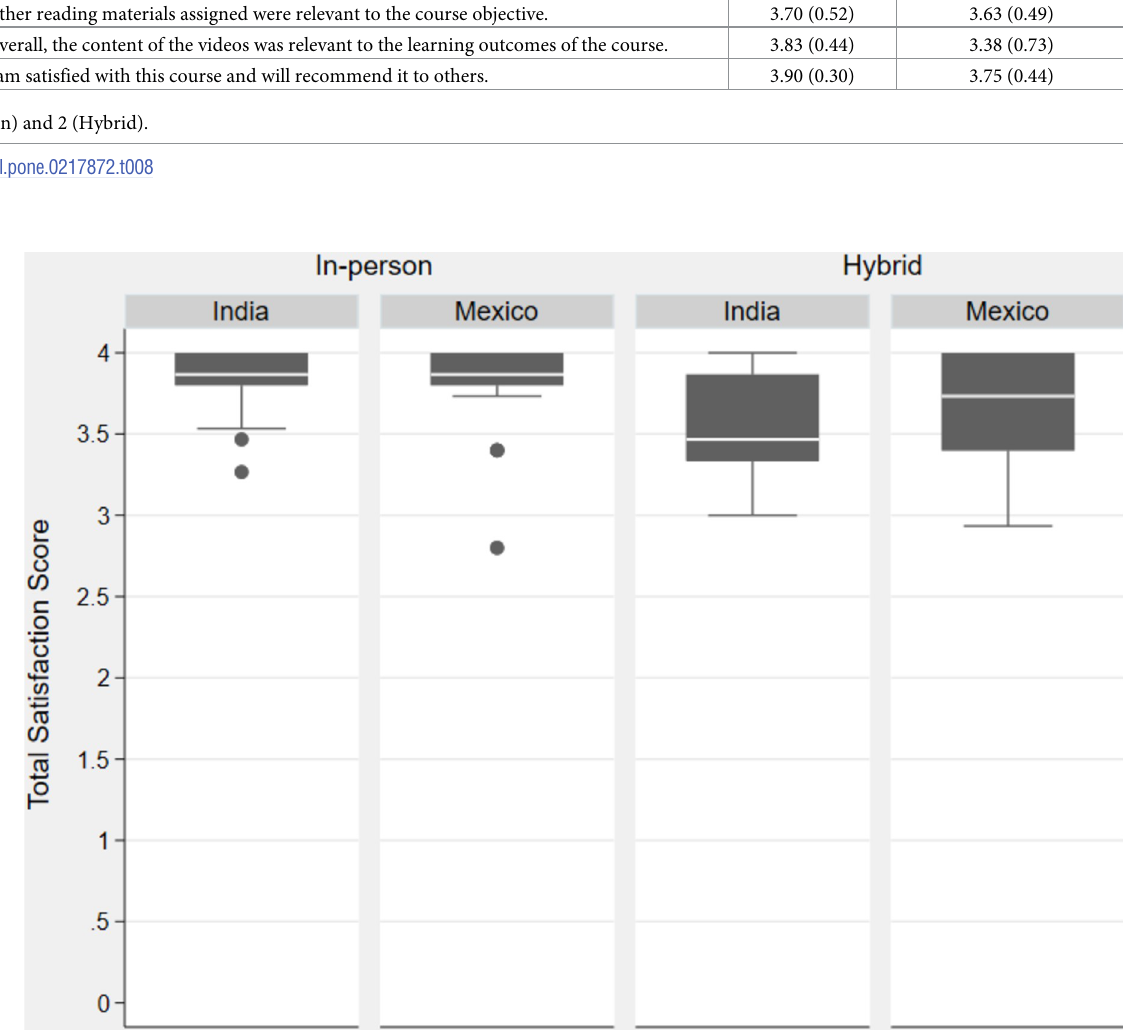
Fig 3. Box plots of satisfaction mean scores by type of intervention and